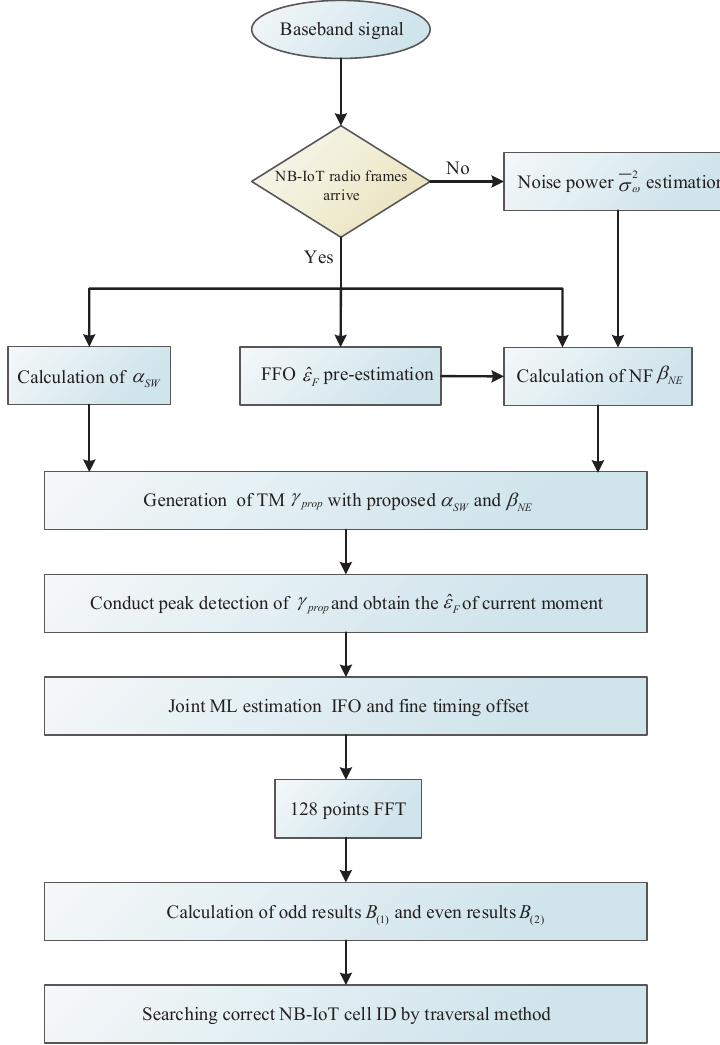
Figure 7. Algorithm flowchart of the proposed cell search